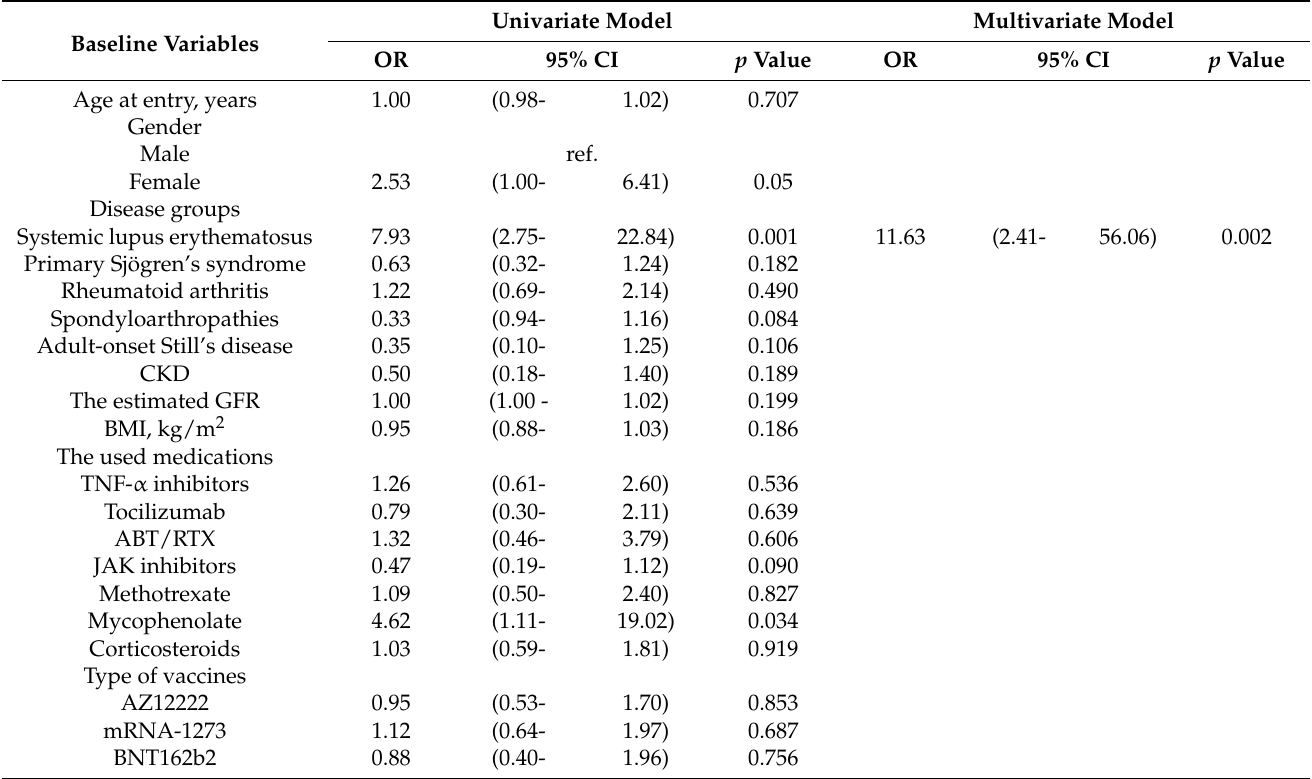
Table 5. Logistic regression analysis for predicting an augmented titer of